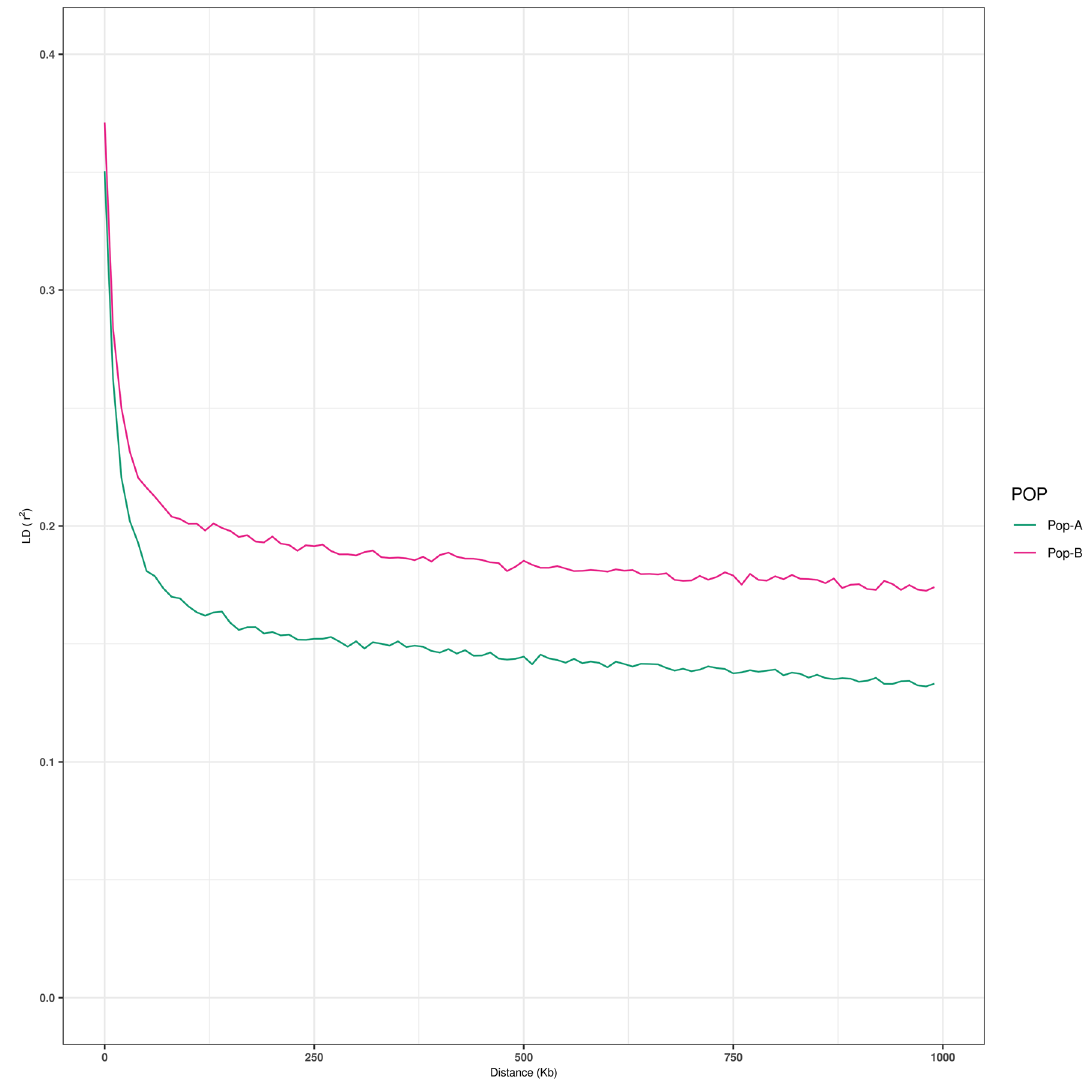
Figure 1. Decay of average linkage disequilibrium ( r 2 ) over distance across the two farmed populations. Different color lines represent populations: Pop-A = green, Pop-B =